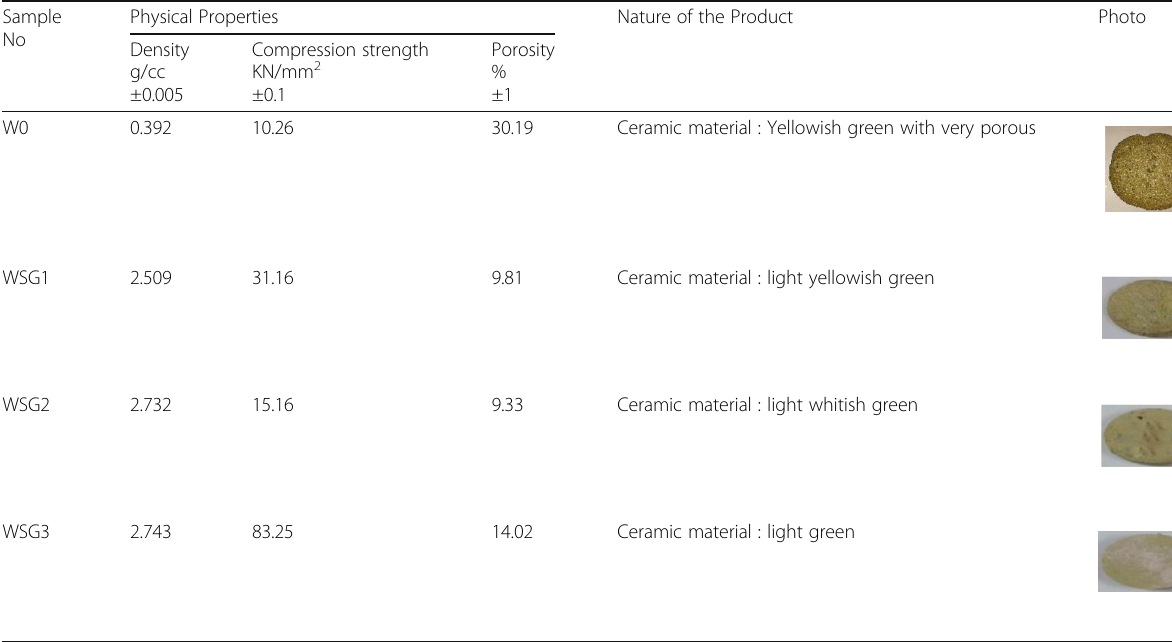
Table 5 Some properties of W0, WSG1, WSG2 and WSG3 samples sintered at 900 °C/2h Sample Physical Properties Nature of the No